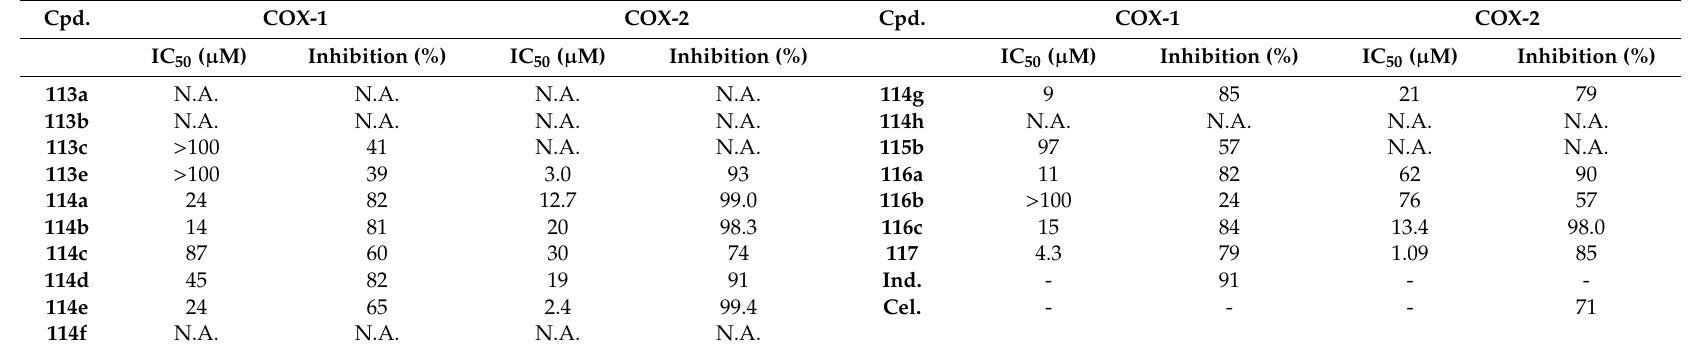
Table 17. IC 50 and inhibition % of PGE 2 production via COX-1 and COX-2, in human whole blood [82].